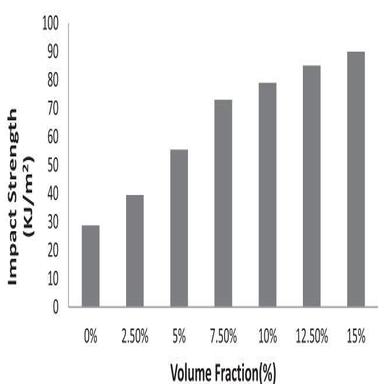
The effect of the volume fraction of wool on impact strength for epoxy volume percentage (0–15%).